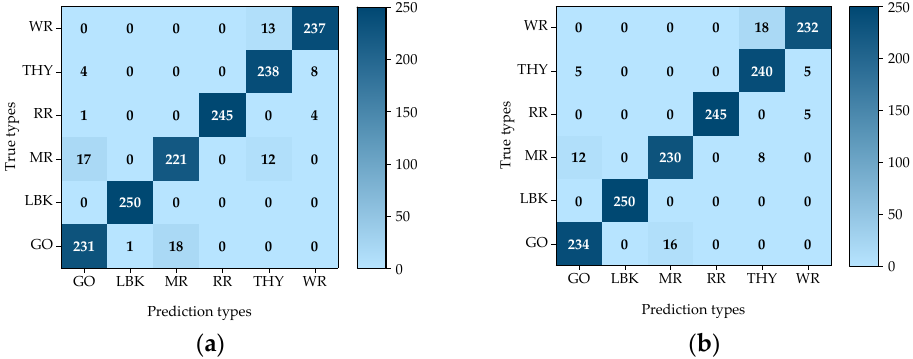
Figure 11. Confusion matrices in perfume experiments. ( a ) The confusion matrix obtained by XGBoost; ( b ) The confusion matrix obtained by LightGBM.